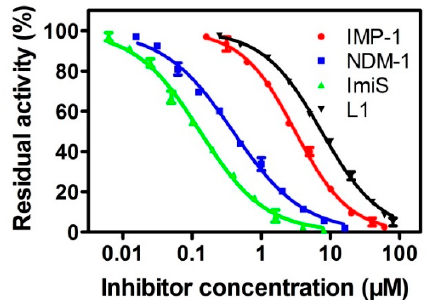
Figure 2. Inhibition curves of DC1 against NDM ‐ 1, IMP ‐ 1, ImiS and L1.